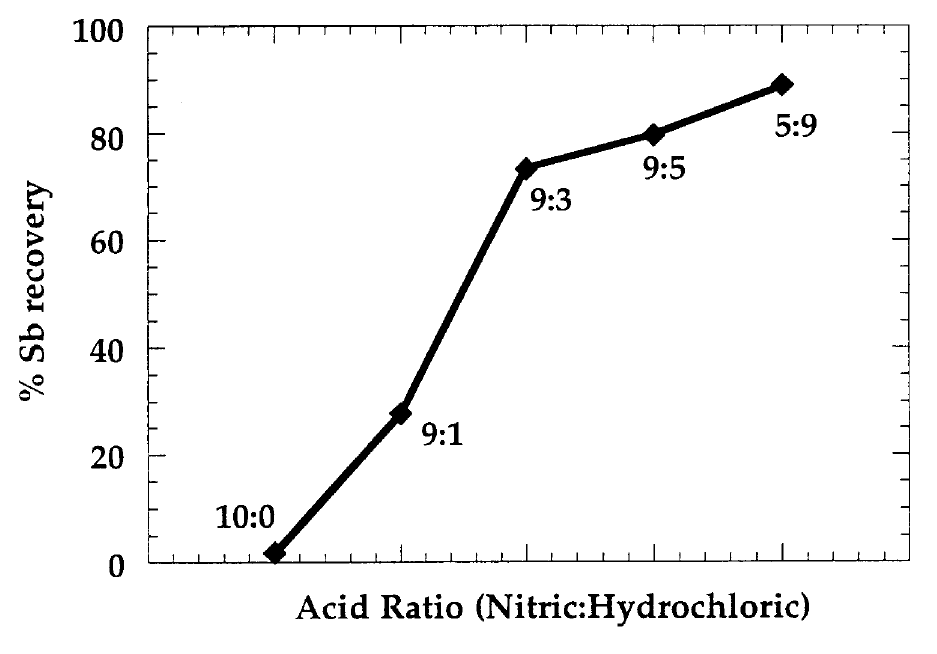
PERCENT RECOVERY OF ANTIMONY FROM NIST SRM 2710 (MONTANA SOIL) VERSUS VARIOUS COMBINATIONS OF NITRIC AND HYDROCHLORIC ACIDS (N=6)